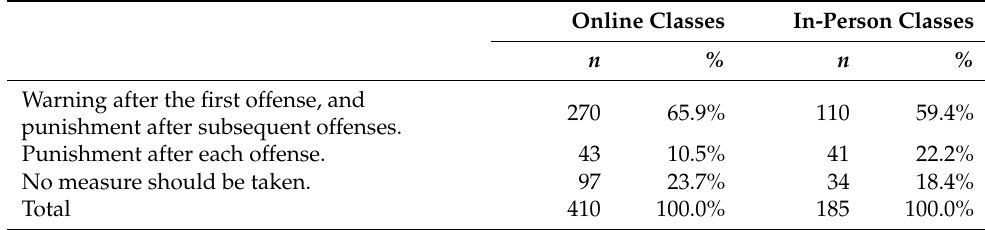
Online Classes In-Person Classes